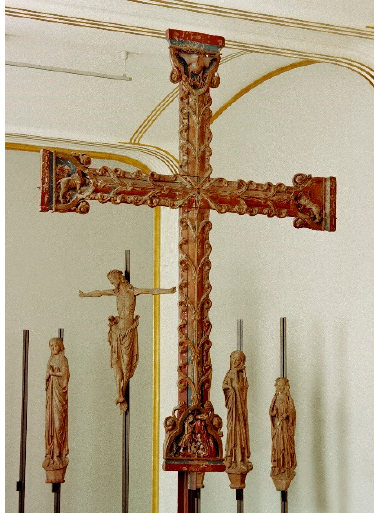
Figure 2. Triumphal Cross from Borre. Polychrome oak, c.1200. Oslo, Museum of Cultural History, Inv. No. C6130. Photo: Ann-Christine Eek (CC BY-SA 4.0).